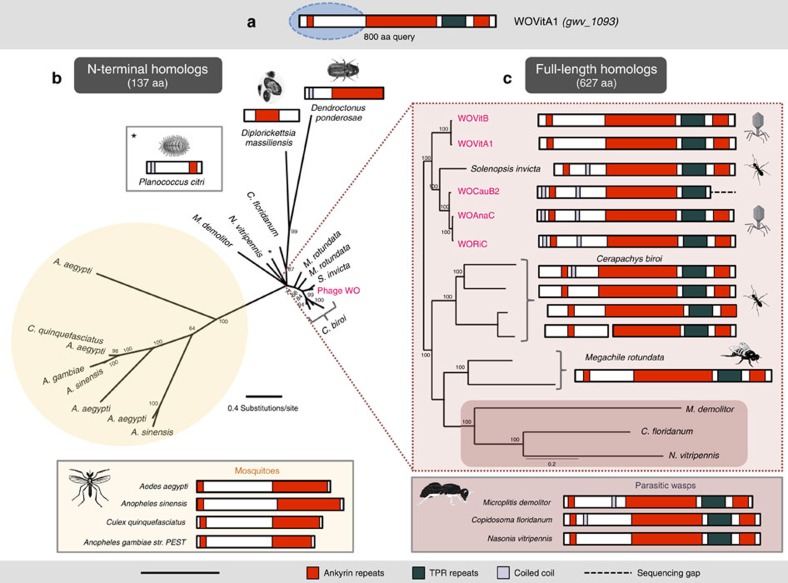
Related TPR and ankyrin proteins support lateral genetic transfer.(a) A BLASTP query of WOVitA1's gwv_1093 N terminus reveals homologues in mosquitoes, ants, beetles, a mealy bug, a solitary bee and one obligate intracellular gammaproteobacteria. Bayesian phylogenetic trees were constructed based on (b) a 137-aa alignment of all homologues with E-value <e−40 using the LG+G model of evolution. (c) To resolve taxa closest to phage WO, trees were reconstructed based on a 627-aa alignment of all homologues with an E-value of 0 using the JTT+I+G model of evolution. Isoforms were removed from each alignment. Both trees are unrooted. Consensus support values are shown at the nodes. Chromosomal neighbourhood analyses of available animal genome sequences indicate that animal homologues to the phage WO protein are on contigs with other animal genes. Scale bar, 1,000 amino acids.